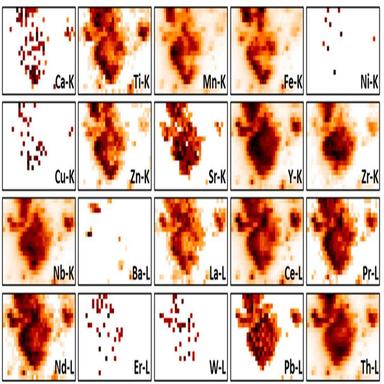
μ-XRF elemental maps of a soil particle from the Bolladalen site. The XRF lines of La-L, Pr-L and Nd-L are strongly overlapped with Ce-L. Map size: 1650 � 900 μm2, 50 μm step size, 1 s/pixel.